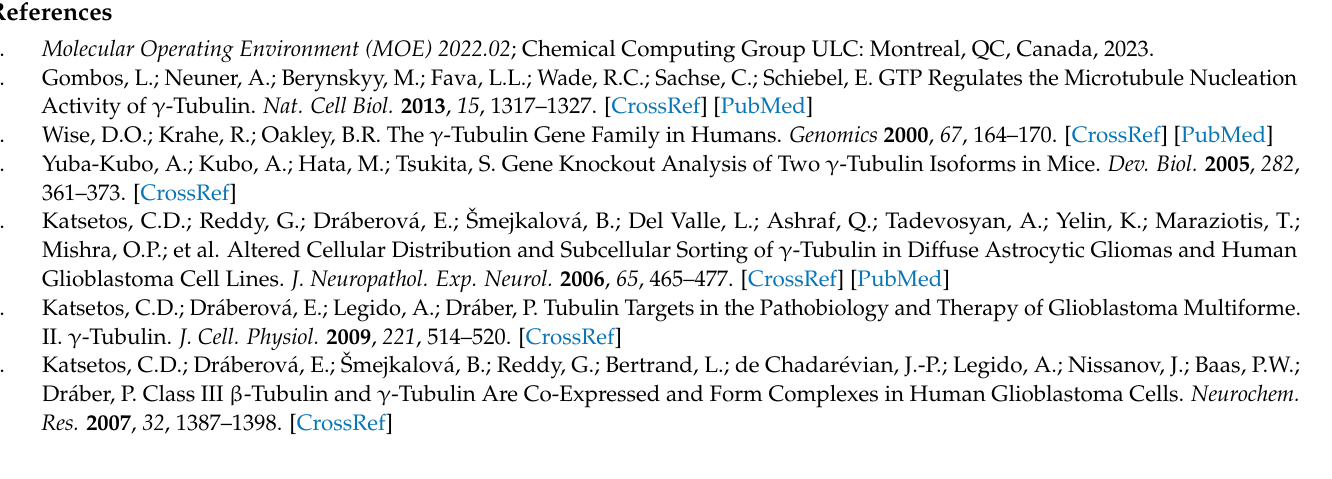
Figure A4. RMSD plots of the MD simulations of γ tubulin in complex with the investigated